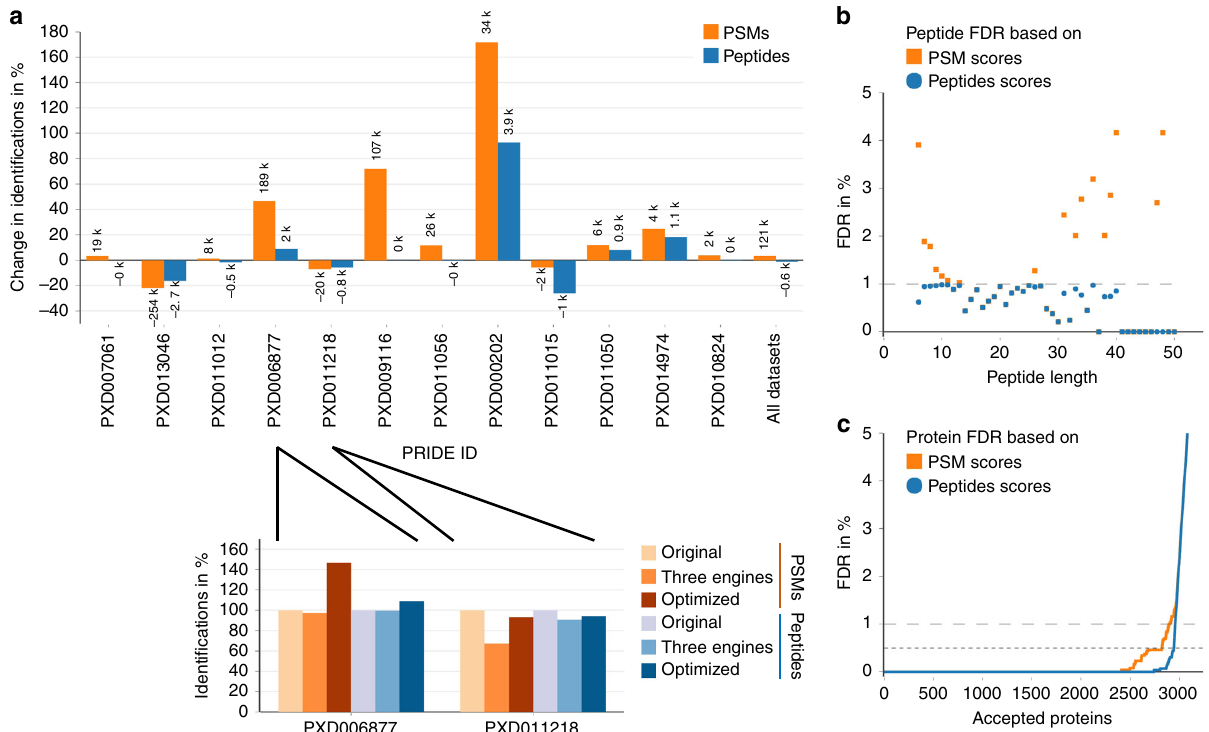
Fig. 2 Optimized reanalysis of datasets and strict control of FDRs. a A uni fi ed dataset reanalysis was performed with Ursgal 29 , including search parameter optimization (parameter sweep iterating through all combinations of a set of four different precursor mass tolerances, four fragment mass tolerances and ten instrument offsets) as well as a combination of three protein database search engines. Results were compared with the original identi fi cations reported for each dataset and differences are given for the number of PSMs (orange) and identi fi ed peptide sequences (blue) on a percentage basis (height of the bar, 0% corresponds to the original results) and as absolute numbers (indicated above/below each bar) for each dataset. For two exemplary datasets, the effects of using three protein database search engines and an optimized reanalysis, including optimization of search parameters, as well as the combined PEP approach 29,30 , are shown in comparison to the original results (normalized to 100%) in the bottom panel. b For each peptide length, the FDR for all peptide sequences within this group was determined after (i) including all PSMs with a PEP ≤ 1% (orange) and (ii) adjusting the FDR on peptide level (blue). c Protein FDRs are shown for the number of accepted proteins (ranked by protein q -value) after (i) including all PSMs with a PEP ≤ 1% (orange) and (ii) adjusting the FDR on protein level using the picked protein FDR approach 31 (blue). It should be noted that fi ltering for identi fi cations based on at least two PSMs removed all decoy hits on the peptide level (resulting in a theoretical FDR of 0%), while it did